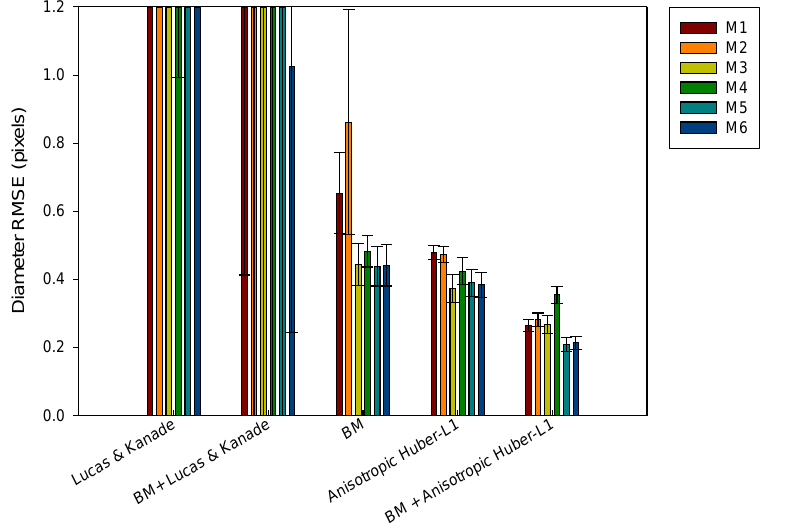
Figure 9. Diameter error results after being evaluated with different